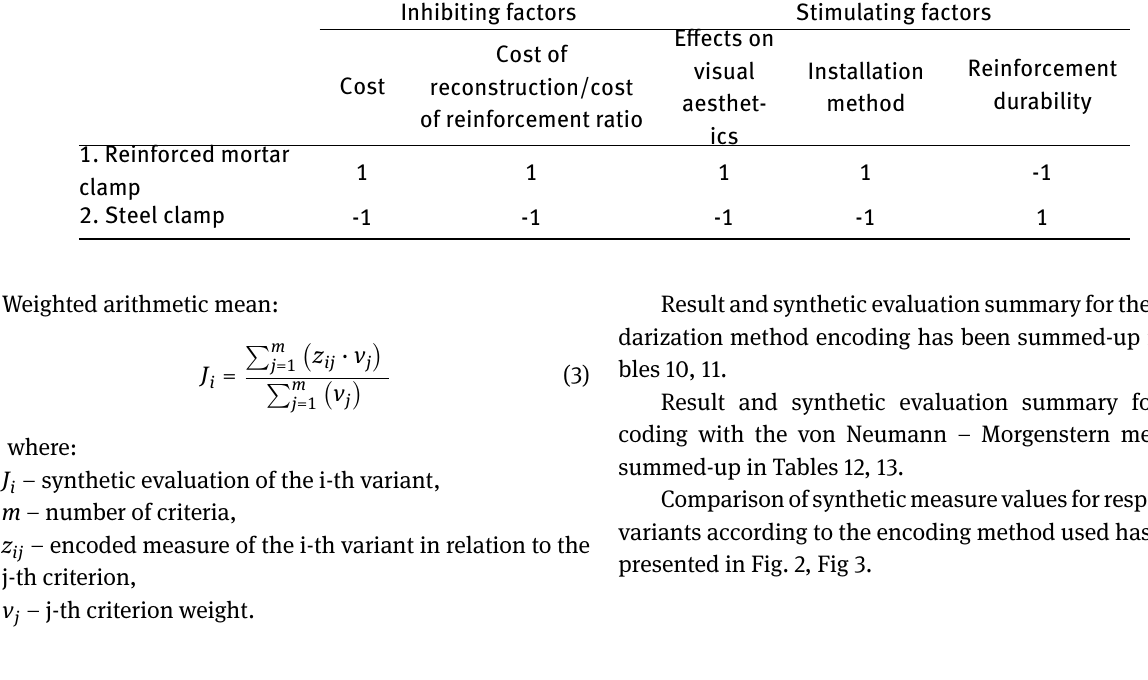
Table 8: Values calculated with the standarization method (own studies) Standarization method